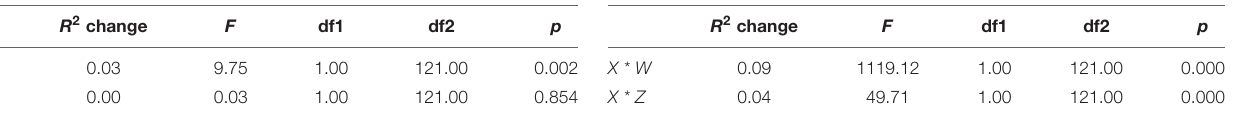
TABLE 16 | R 2 increase due to interaction (StWE).